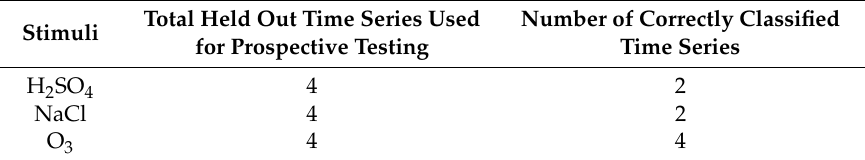
Table 4. Results from prospective study using separate held out data.